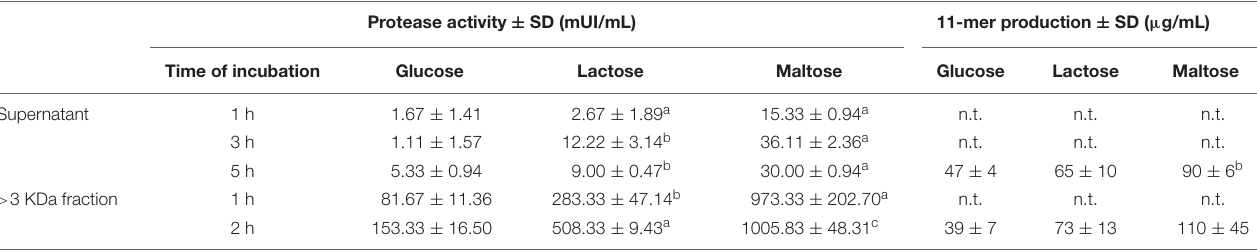
TABLE 4 | Protease activity and 11-mer production of both supernatants and concentrated fractions (higher than 3 KDa) in supernatants obtained with the growth of B. longum subsp. infantis CECT 7210 in the presence of different carbohydrates, at different times of incubation. Protease activity ± SD (mUI/mL) Time of incubation Glucose Lactose Maltose Glucose Lactose Maltose Supernatant